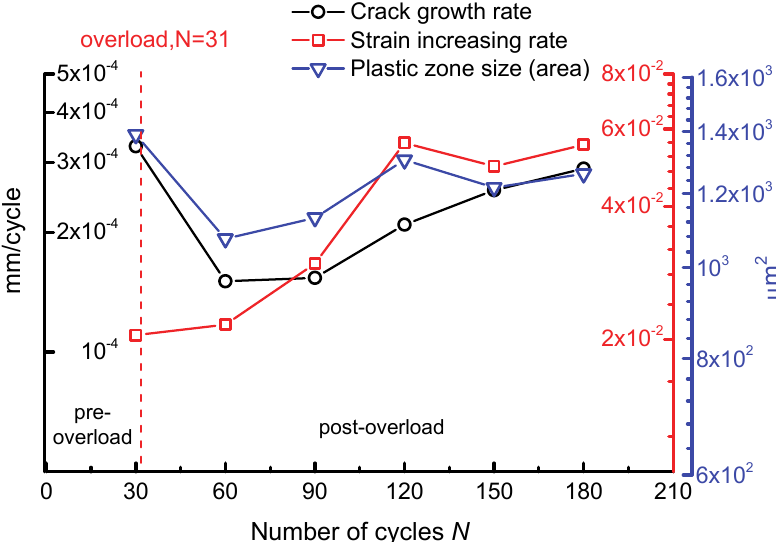
Figure 6: Variations of crack growth rate, strain increasing rate and plastic zone size with number of cycles